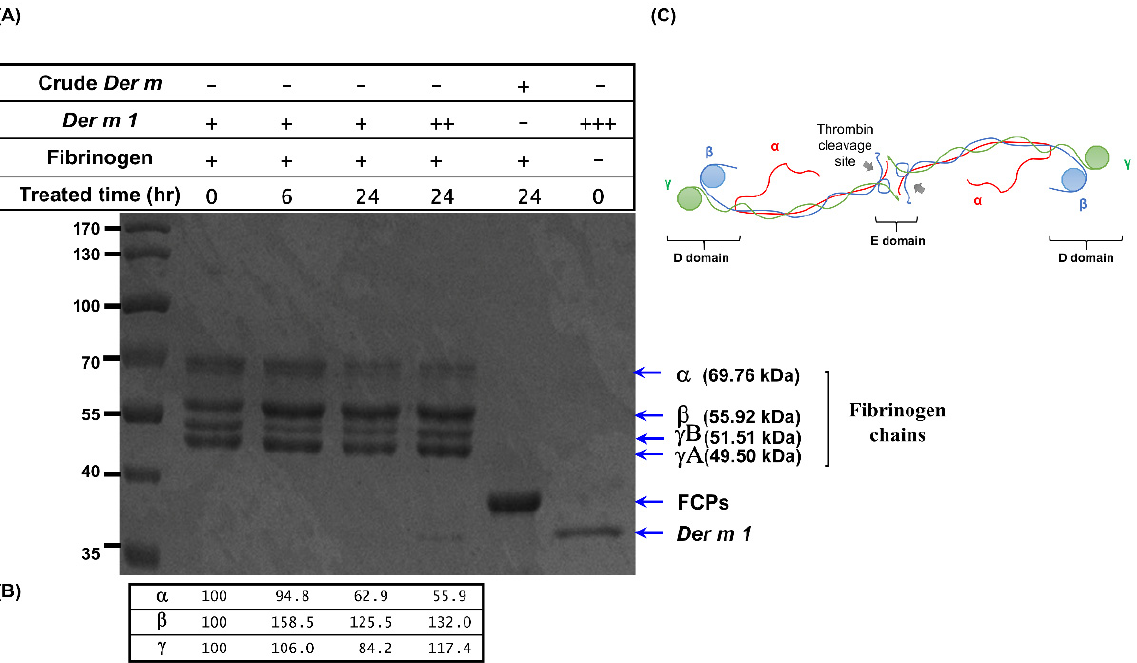
Figure 8. The proteolytic cleavage of fibrinogen by recombinant Der m 1 protease. ( A ) The fibrinogen (5 mg/mL) was incubated with Der m 1 (+: 0.1 mg/mL; ++: 0.2 mg/mL; +++: 1.0 mg/mL) and/or crude Der m (0.1 mg/mL) at 37 °C for the indicated time (0, 6, and 24 h) and further analyzed by SDS-PAGE. ( B ) The quantity of α , β , and γ chains remaining in the FCPs mixture showing Der m 1 -mediated degradation of fibrinogen. ( C ) Fibrinogen composed of three different polypeptide chains including α , β , and γ chains. FCPs: Fibrinogen cleavage products.